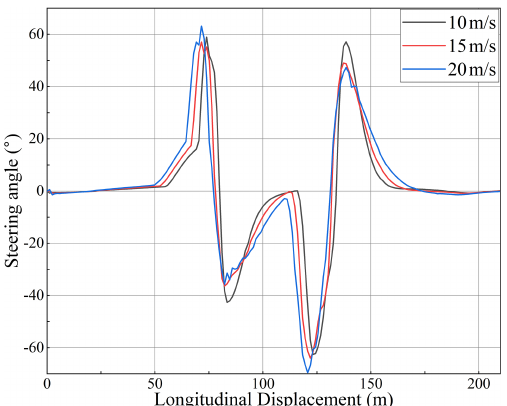
Figure 14. Acceleration of different friction coefficients.